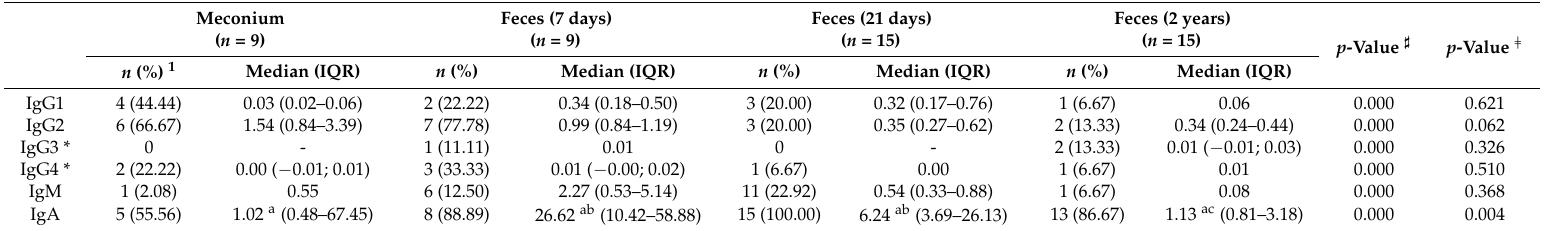
Table 5. Detection and concentrations of immunoglobulins (Ig) in the meconium and fecal samples collected in this